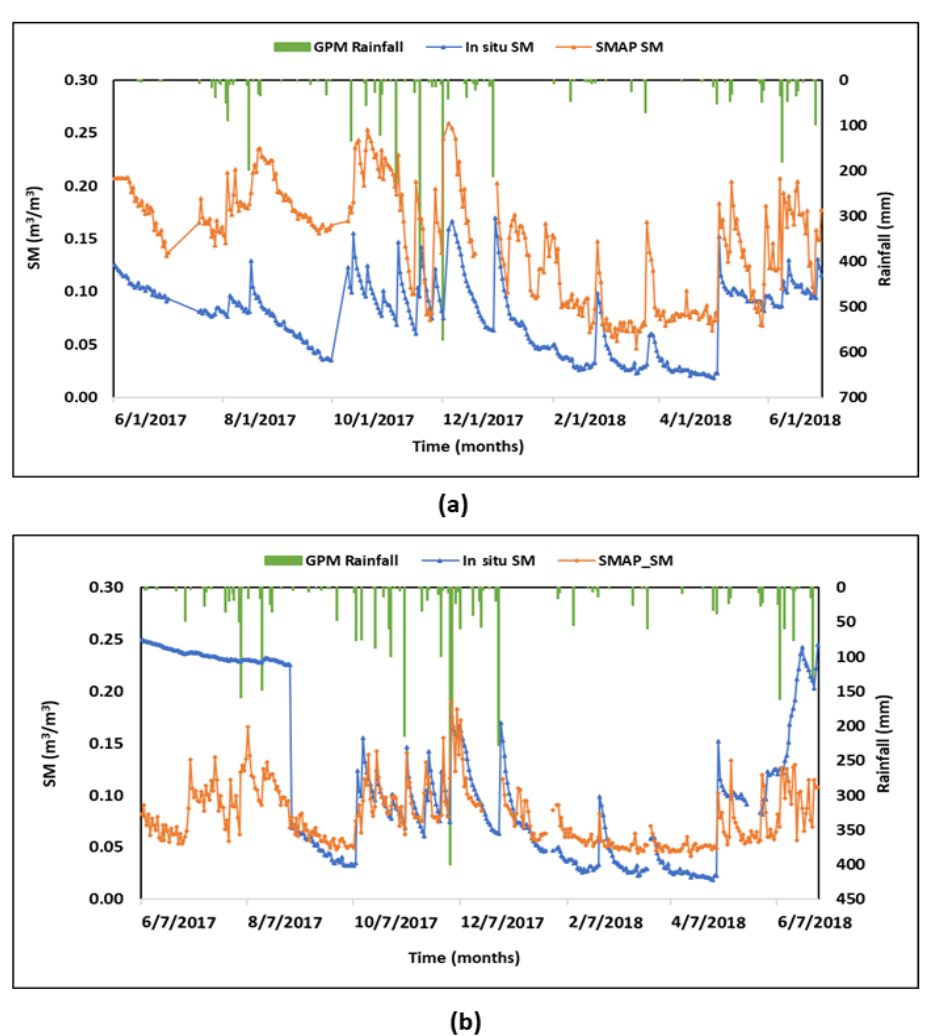
Figure 11. Temporal series plots between the SMAP SM, in situ SM and GPM rainfall for ( a ) Uri Park and ( b ) Yanco, Australia.